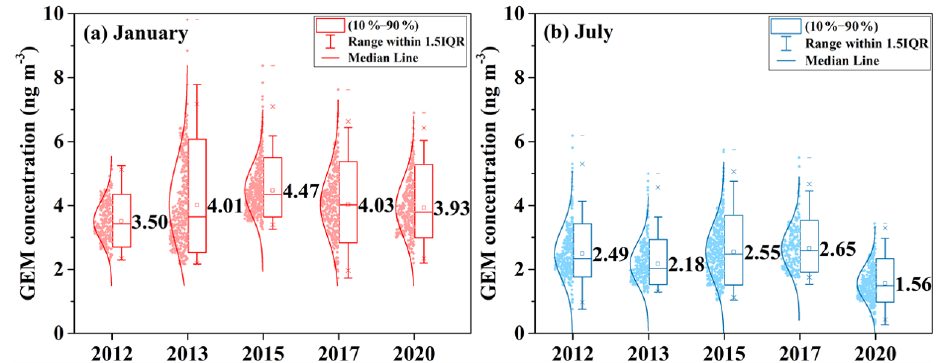
Figure 2. Statistical summaries of gaseous elemental mercury (GEM) concentrations in Xiamen in (a) January and (b) July of the study